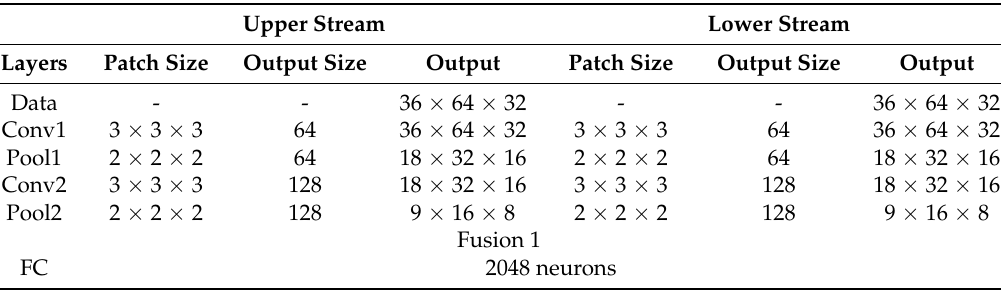
Table 2. Configurations of local